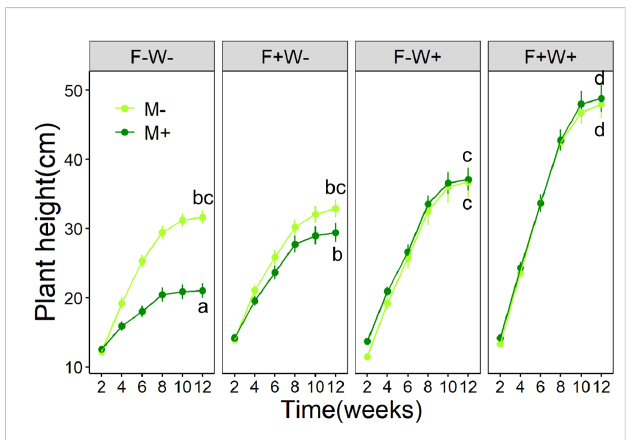
FIGURE 1 Development of plant height over time of Artemisia ordosica plants that were inoculated with the AMF species Funneliformis mosseae (M+) or not (M-) and that were grown under four different combinations of fertilization (F-: no fertilization; F+: fertilization) and water addition (W-: low soil water; W+: high soil water) treatments in a greenhouse. Light symbols: plants without AMF; dark symbols: plants with AMF. Data at the last time point (Week 12) were separately analyzed across all treatments in plot facets and the scatterplot with identical letters are not signi fi cantly different based on Tukey ’ s post hoc test. Statistics are shown in Table